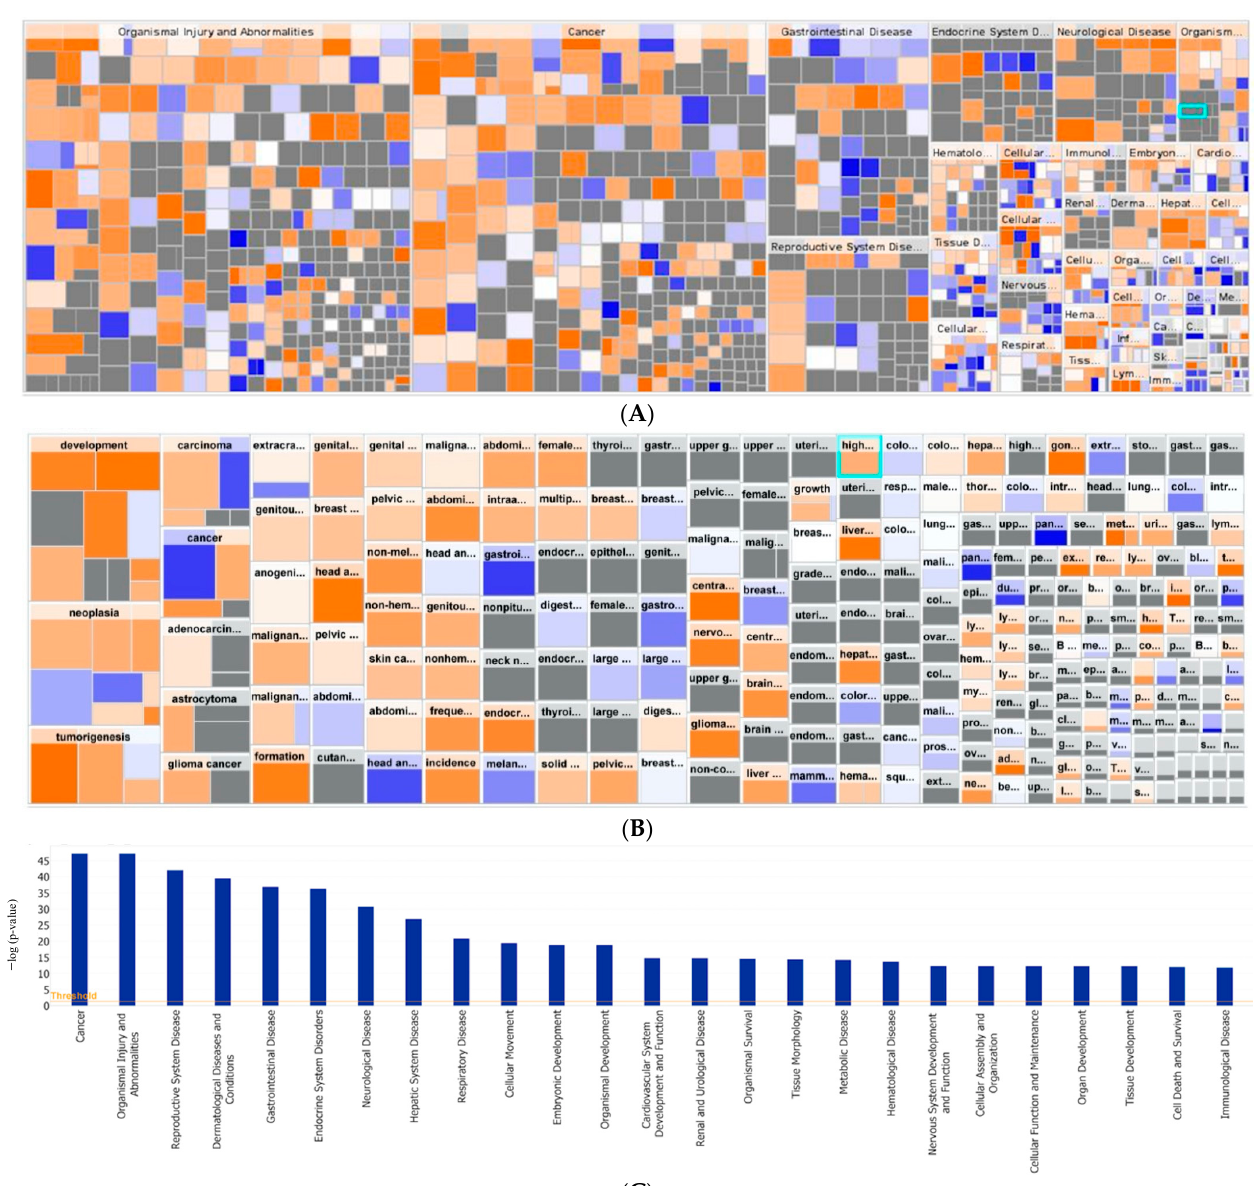
Figure 7. Gene network analysis between carboplatin-resistant and carboplatin-sensitive subjects. ( A ) Heatmap of the network analysis of genes differentially expressed between carboplatin-resistant and carboplatin-sensitive TOs by organ and disease system. The color and intensity of the boxes correlate with the z-score. Blue represents z ≤ 0, and orange represents z ≥ 0. ( B ) Heatmap of network analysis separated by cancer disease process. ( C ) Disease system pathways involved in carboplatin resistance are shown through network analysis of genes differentially expressed between carboplatin-resistant and carboplatin-sensitive